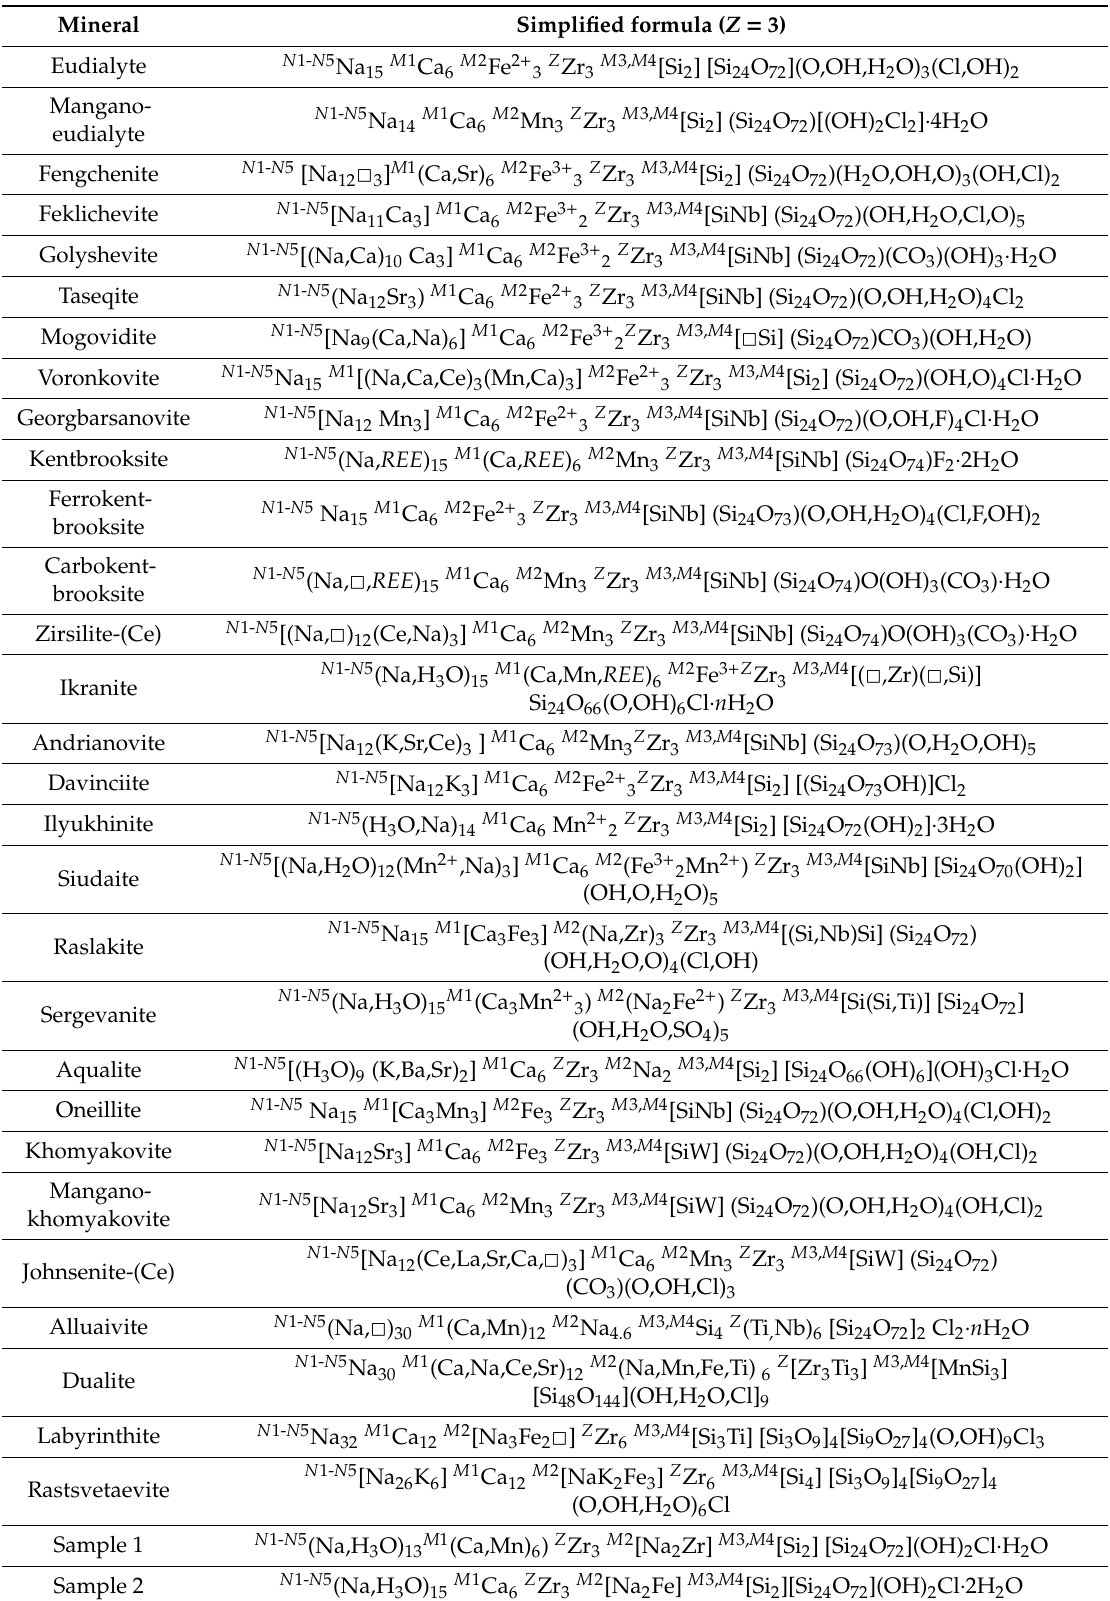
Table 1. Simplified crystal chemical formulae of eudialyte group minerals, including potentially new species (Samples 1 and 2). The key sites are